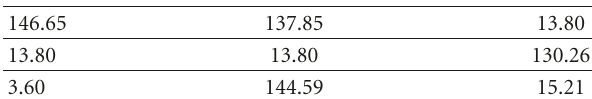
Table 3: Matrix M 3